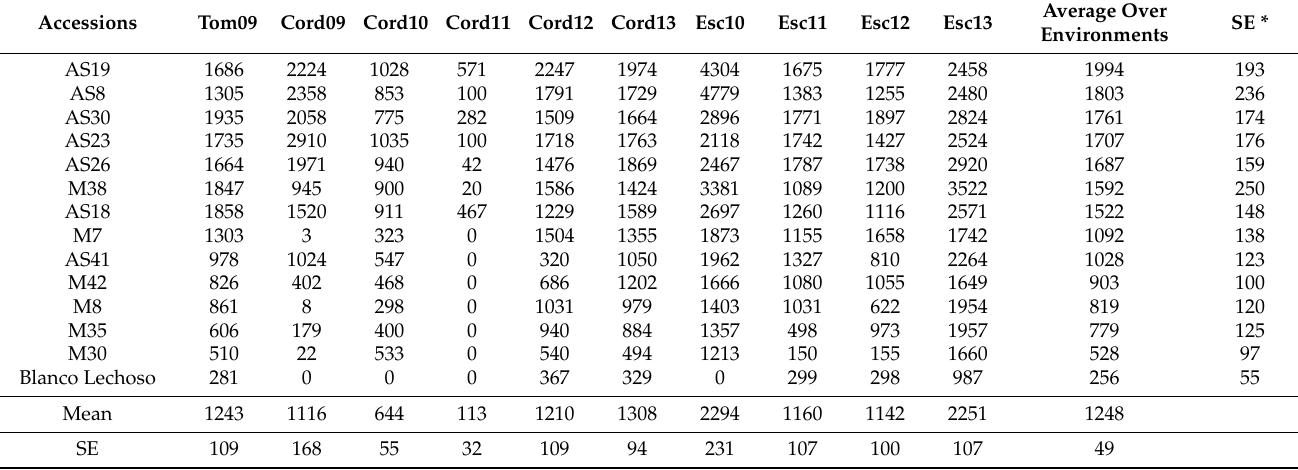
Table 4. Grain yield (kg/ha) of 14 chickpea accessions grown at 10 location–year